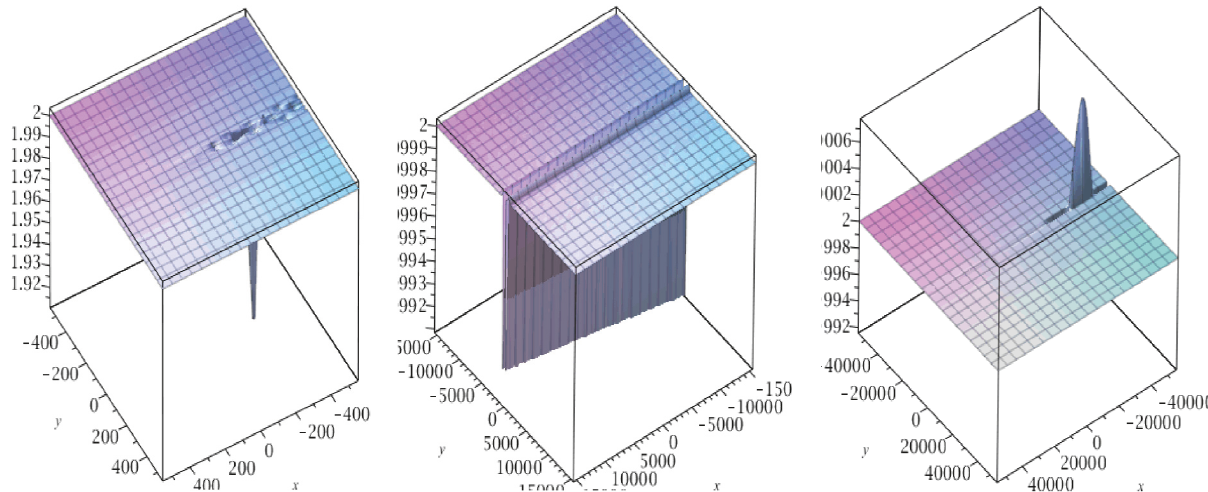
Figure 5: Solution of order 3 to (1), on the left for 𝑡 = 10 , 𝑎 1 = 0 , 𝑏 1 = 0 , 𝑎 2 = 10 6 , and 𝑏 2 = 0 ; in the center for 𝑡 = 100 , 𝑎 1 = 10 6 , 𝑏 1 = 0 , 𝑎 = 0 , and 𝑏 = 0 ; and on the right for 𝑡 = 10 3 , 𝑎 2 2